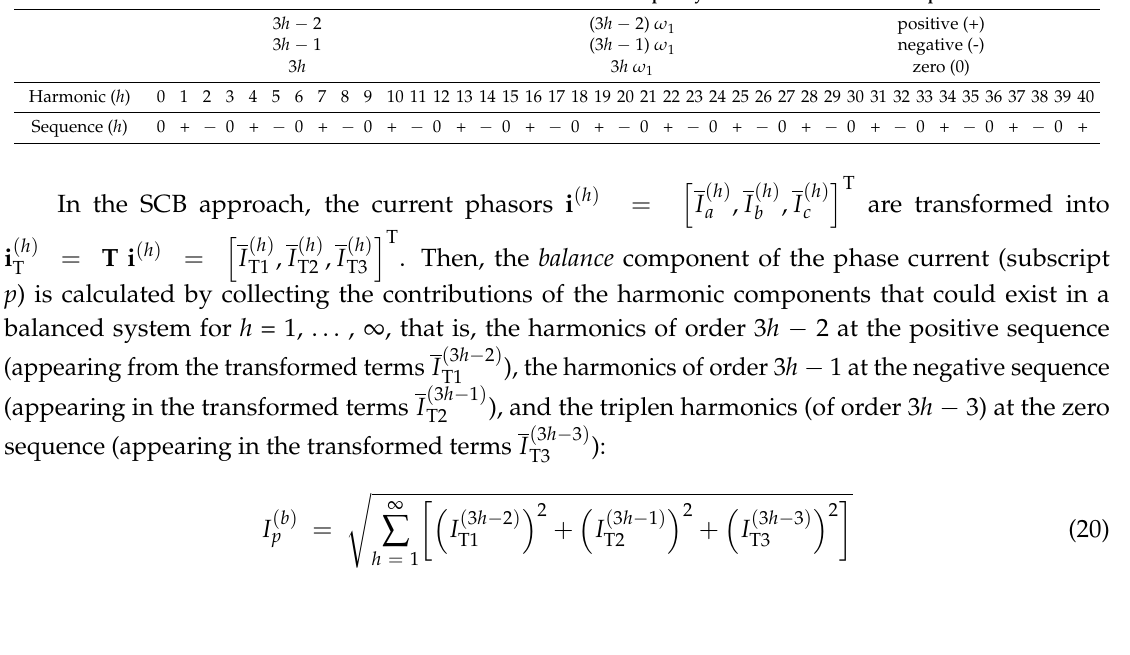
Table 2. Sequences for the different harmonic orders in a balanced three-phase system, h = 0, 1, . . . , ∞ . Harmonic Order Radian Frequency Sequence 3 h −